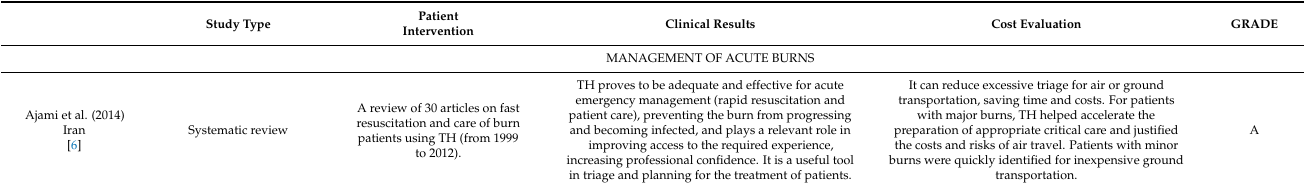
Table 1. Summary of the studies included in the systematic